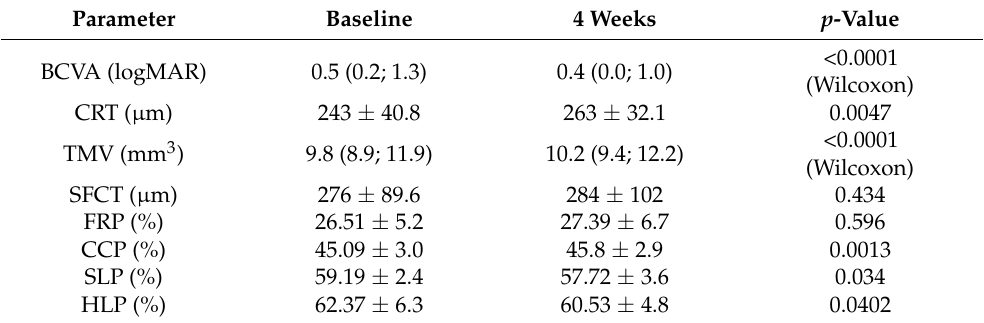
Table 2. Comparison of best-corrected visual acuity (BCVA), anatomical and functional parameters before and 4 weeks after silicone oil